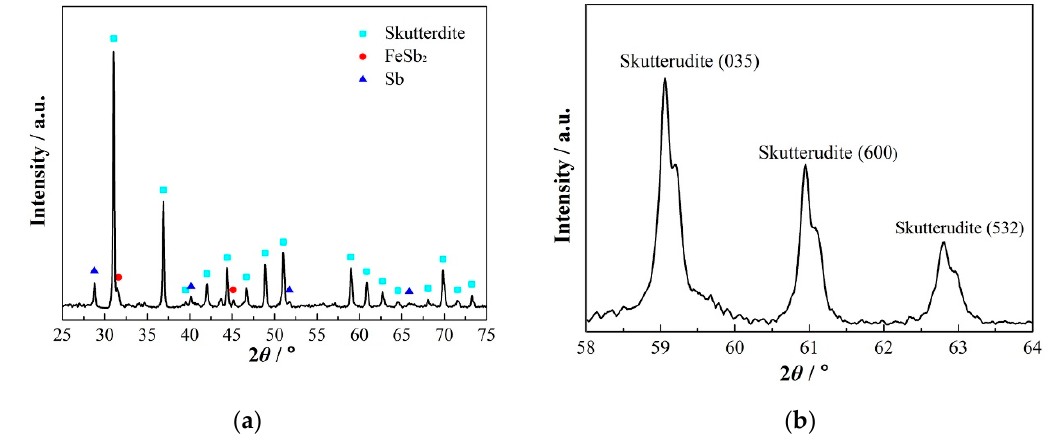
Figure 4. ( a ) The XRD pattern of the spun ribbons, with three phases: the skutterudite phase, the FeSb2 phase and the Sb phase. The main phase is the skutterudite phase. ( b ) The XRD pattern of the spun ribbons in the high 2-theta angle, the spinodal twin peaks of the skutterudite phase, were observed.